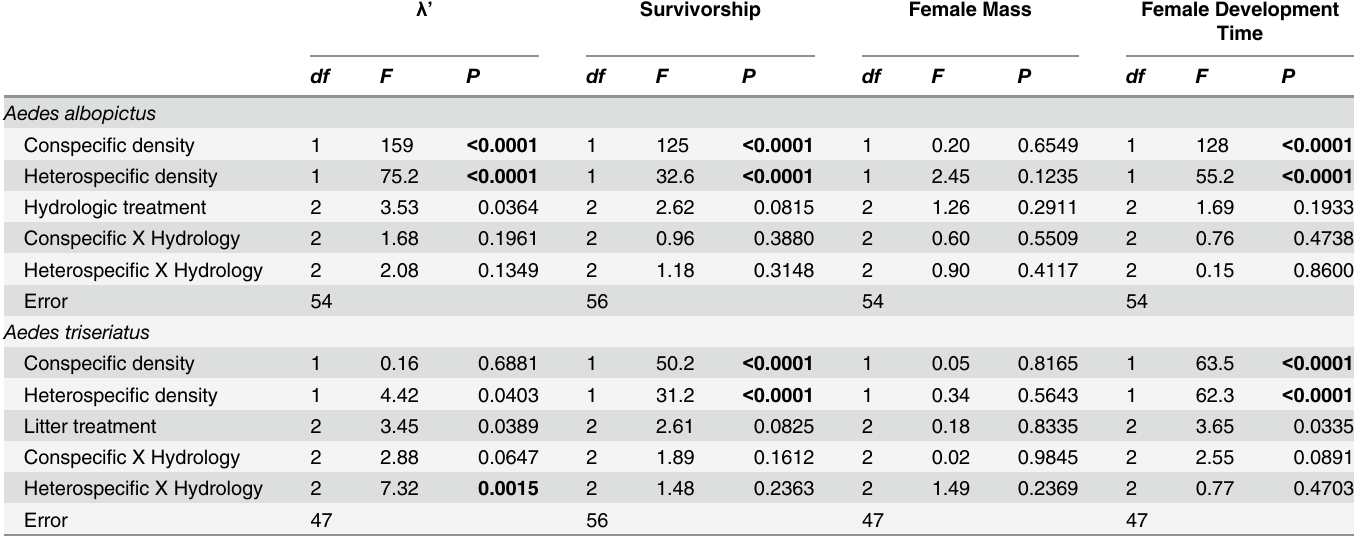
Table 2. ANOVA results testing effects of mosquito densities and hydrologic treatment on λ ' , survivorship, female mass, and female development time of A . albopictus and A . triseriatus in habitats exposed to one of three hydrologic treatments (dry, flooded,